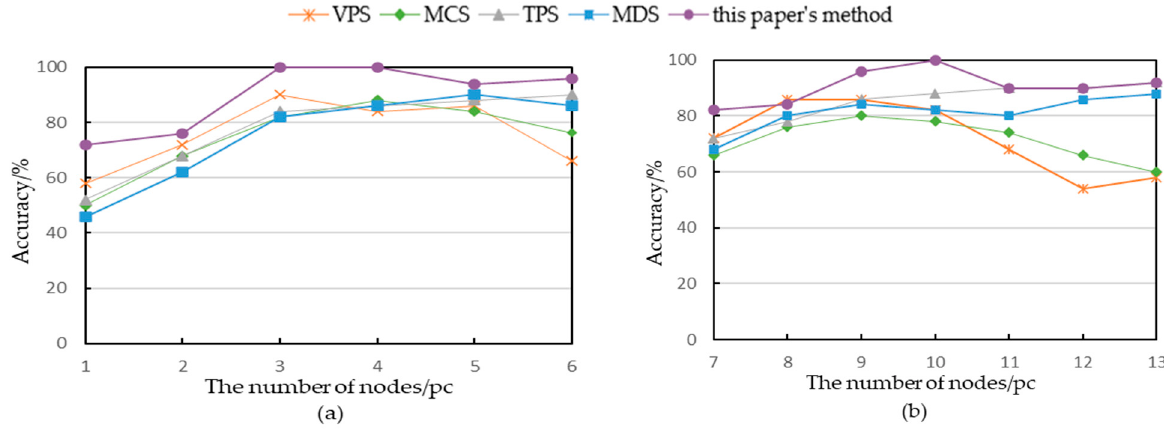
Figure 9. Accuracy comparison of fi ve methods: ( a ) real dataset; ( b ) simulation dataset.